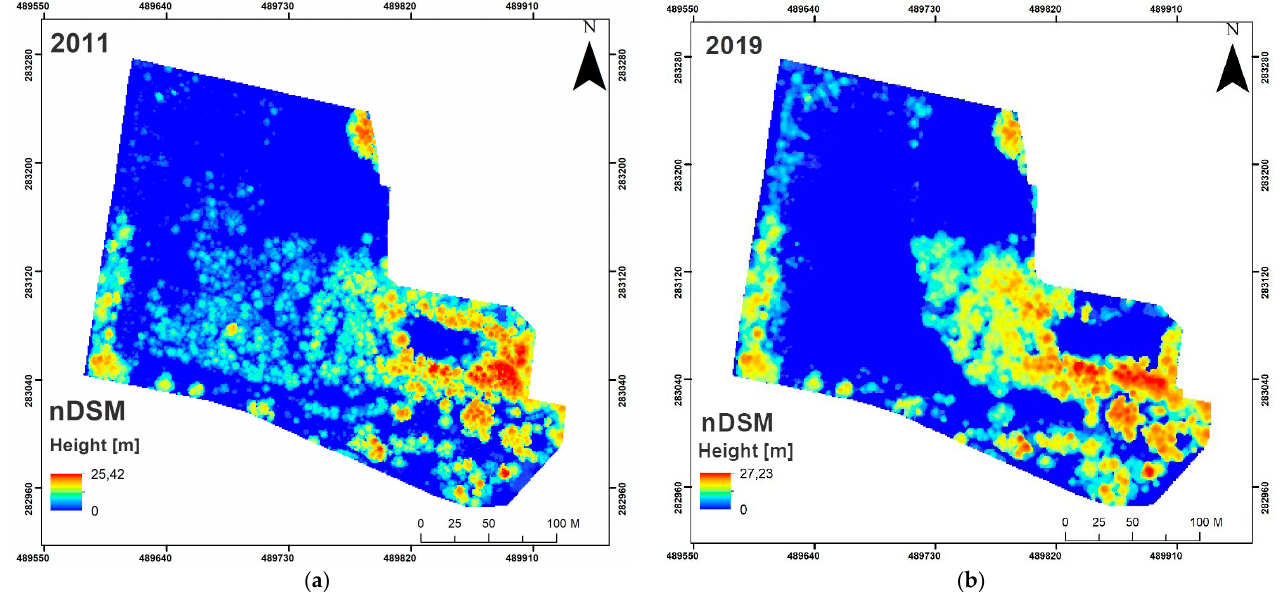
Figure 6. The normalized digital surface model (nDSM): ( a ) 2011; ( b ) 2019. Table 1. LiDAR metrics for vegetation—mean values of height, std. dev. of height, canopy cover. Year Height [m] Std. dev. of Height [m]